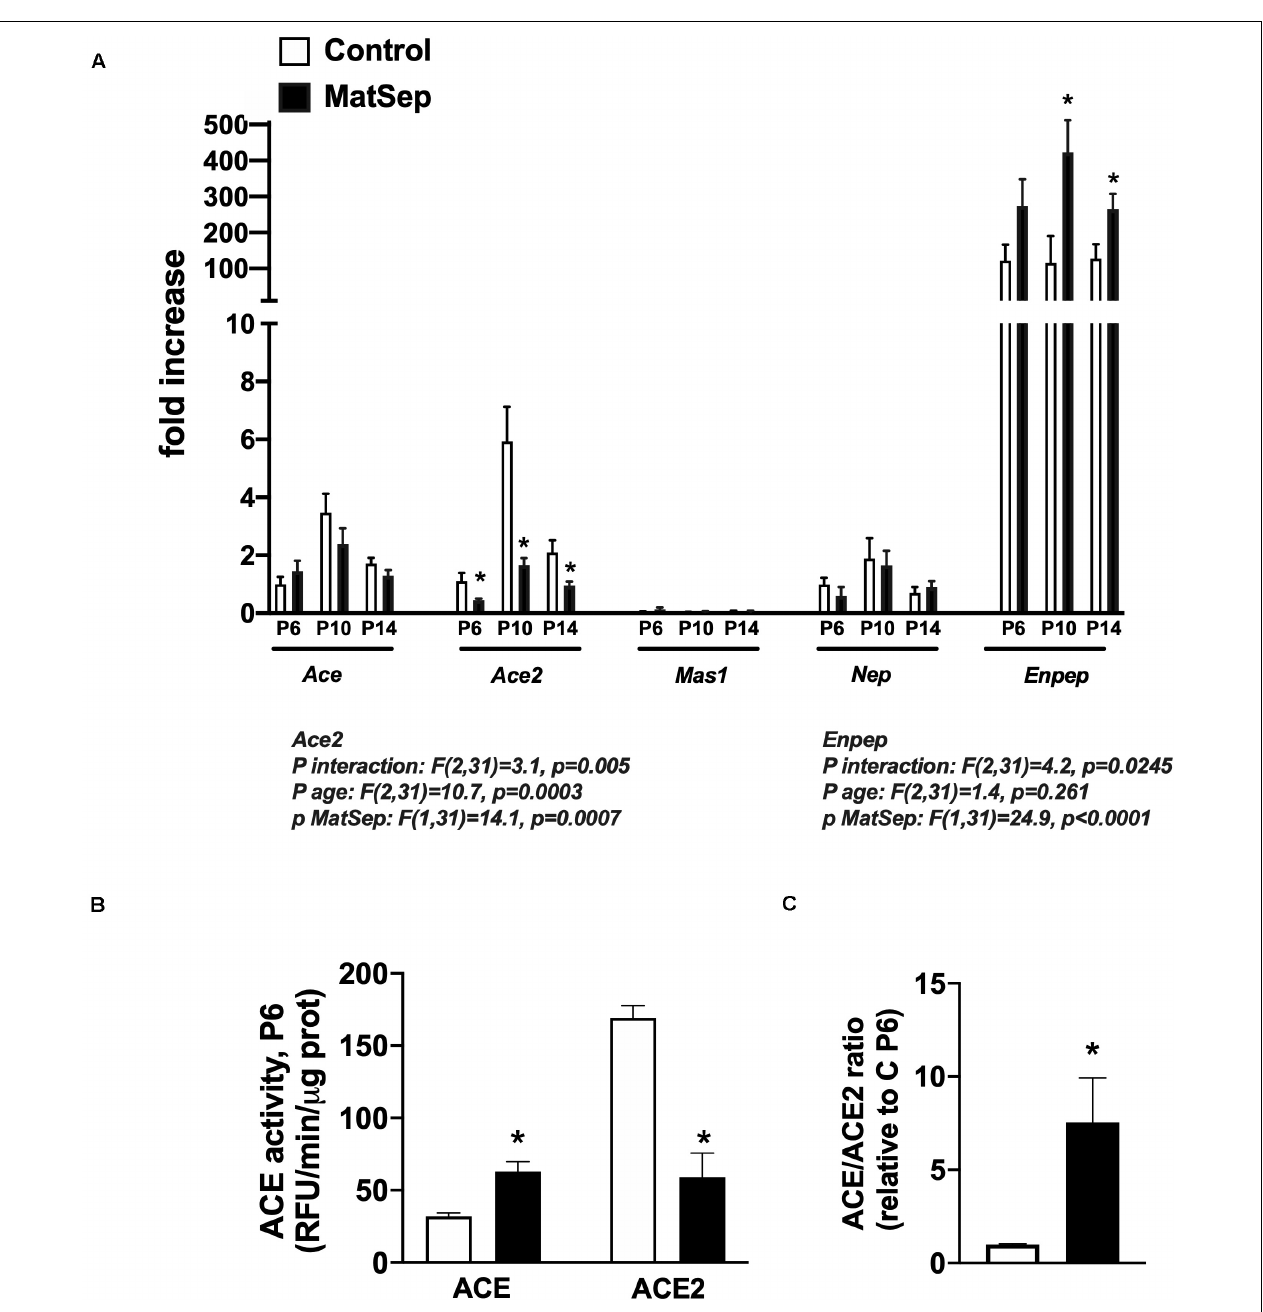
FIGURE 5 | Effect of maternal separation (MatSep) on intrarenal RAS components at postnatal day 6, 10, and 14 in male neonates: (A) Ace, Ace2, Mas1, Nep, and Enpep; (B) ACE and ACE2 enzymatic activity; (C) ACE/ACE2 ratio. * p < 0.05 vs. C. n = 4–8 per